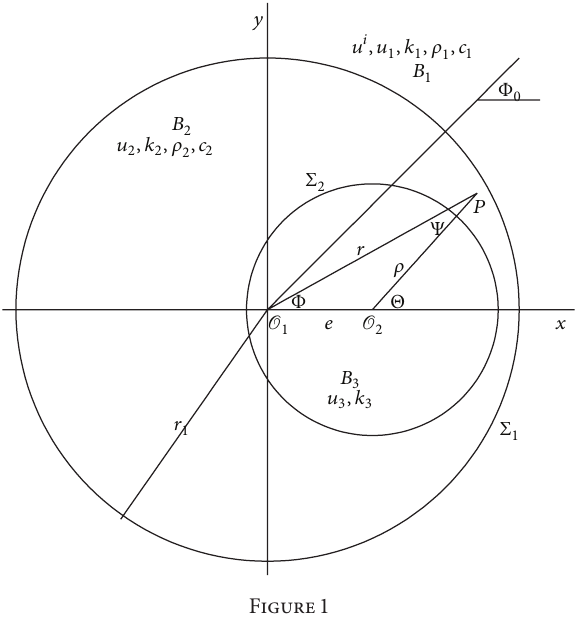
fourth-order SRCs and with those of the scattering of plane waves by a concentric penetrable cylinder